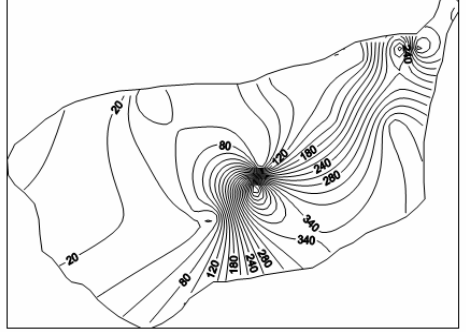
Figure 9. Seasonal variations of Cl